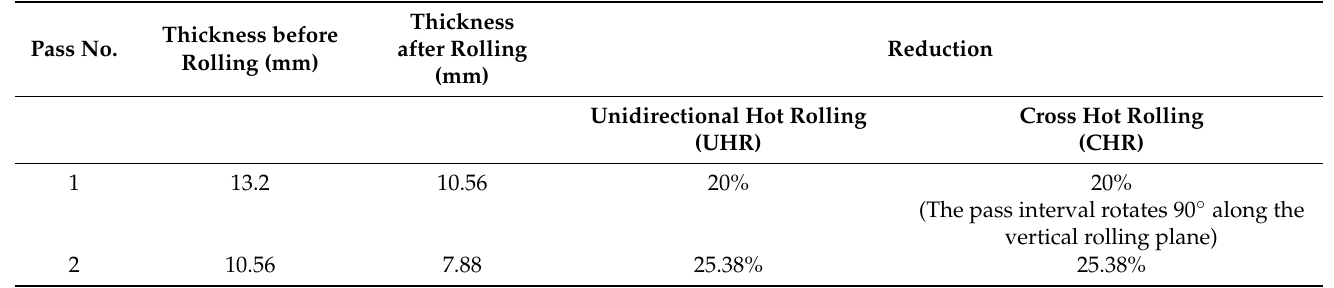
Figure 1. Schematic diagram of the preparation process of rolled molybdenum plates. Pure molybde- num powder was formed by cold isostatic pressing, sintering in an intermediate-frequency furnace, treated in a heating furnace and pressed into molybdenum sheets by a two-roll hot-rolling mill. Table 1. Expected rolling process and change in molybdenum plate thickness before and after